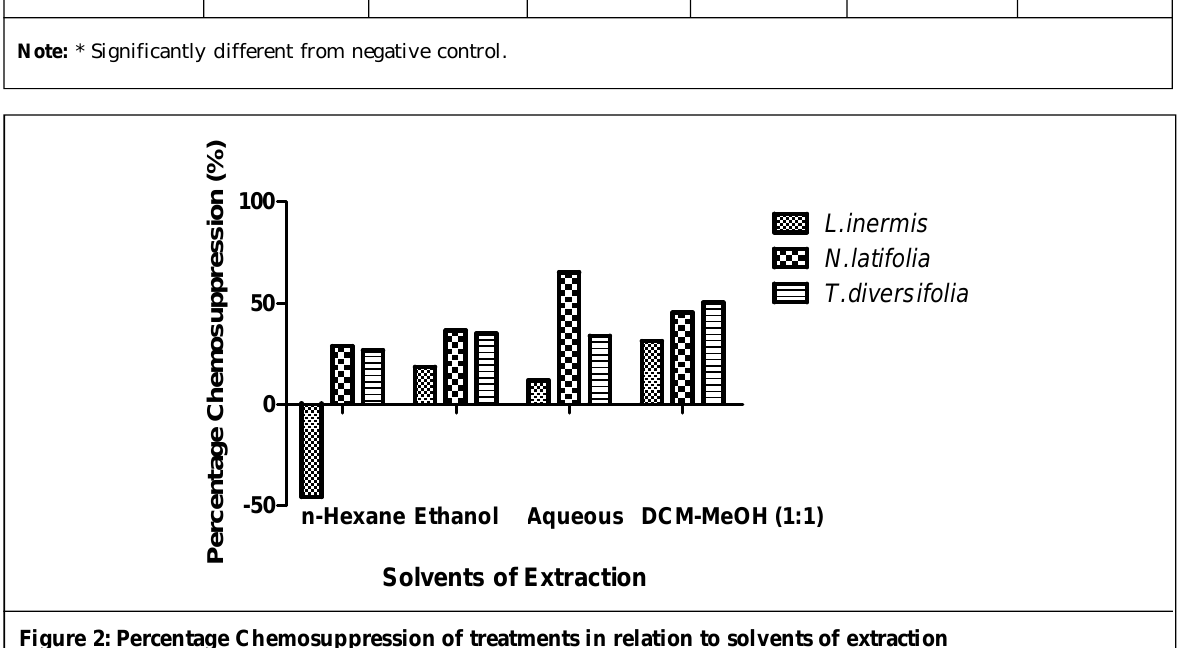
Figure 2: Percentage Chemosuppression of treatments in relation to solvents of extraction on day 6 post-infection and treatment best antiplasmodial effects on the P. berghei infected mice when compared to other solvents’ extracts on days 4 and 6 post-infection (Figures 1 and 2).